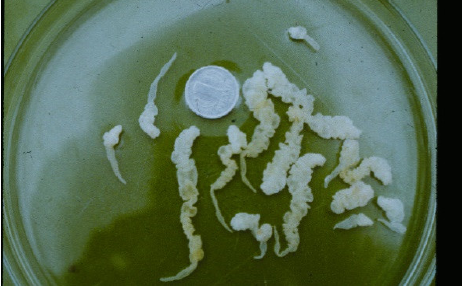
Figure 9. H. taeniaeformis scolex.